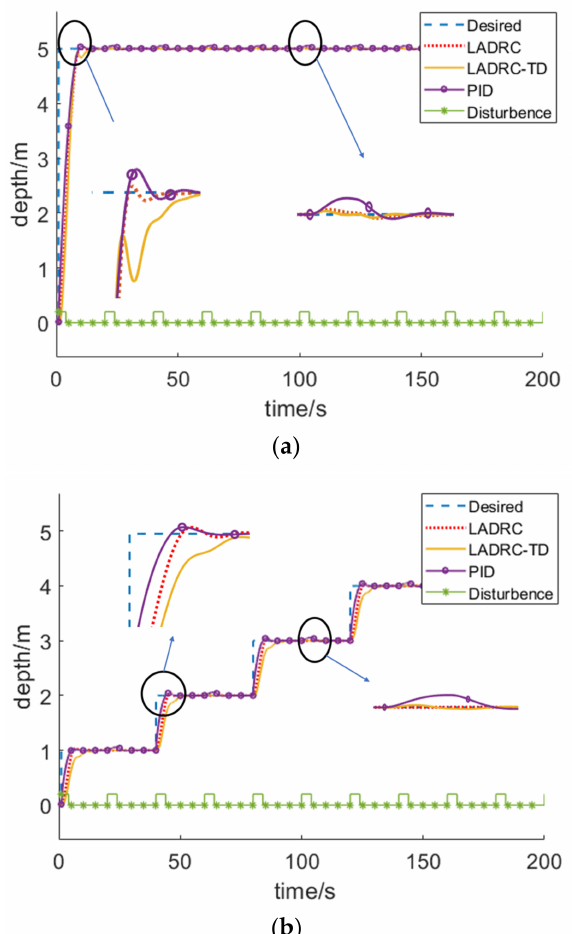
Figure 9. Simulations of depth control with PID, LADRC, and LADRC-TD. ( a ) Long-span-step response; ( b ) multi-step